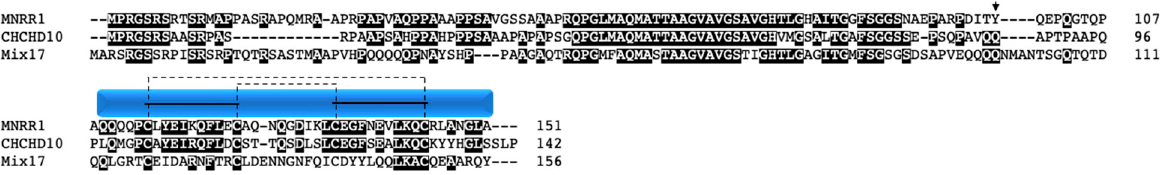
Figure 11. MNRR1/CHCHD2, CHCHD10, and Mix17. Alignment of human MNRR1/CHCHD2 and CHCHD10 (D10) and yeast Mix17 protein sequences. Black boxes indicate conserved residues. Human sequence annotation is as follows: Blue box indicates the CHCH domain. Solid black lines indicate the twin CX 9 C motif. Dashed lines indicate the cysteine pairs that form structural disulfide bonds. The arrow indicates a residue of interest discussed in this review.